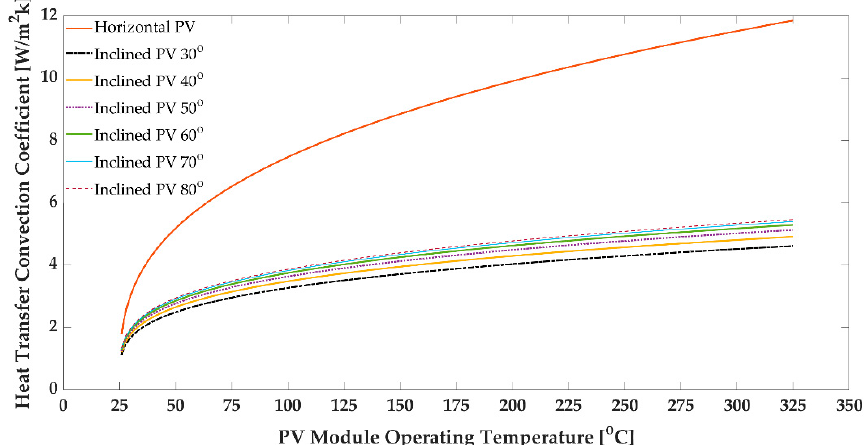
Figure 5. Heat transfer free convection coefficient vs. PV module operating temperature.